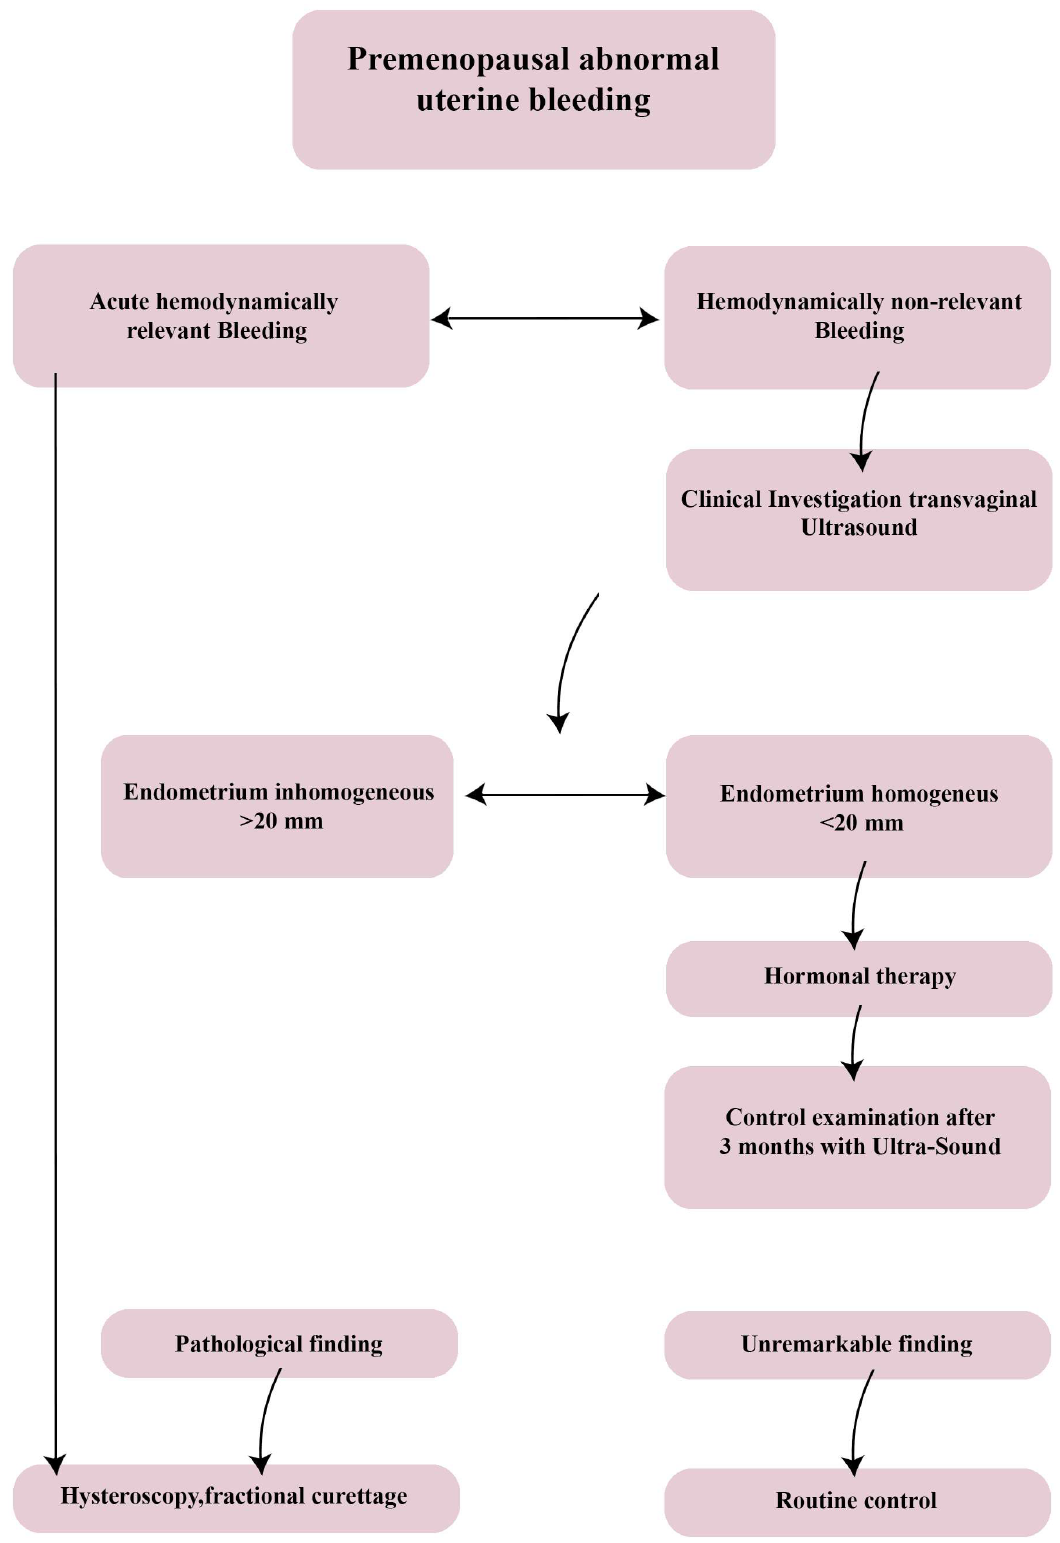
Figure 1. Diagnostic algorithm for abnormal premenopausal uterine bleeding. In the clinical work-up, a hemodynamically significant bleeding should be investigated directly with a II level exam/hysteroscopy, while a leakage of blood of inferior amount is generally evaluated in first instance by a transvaginal